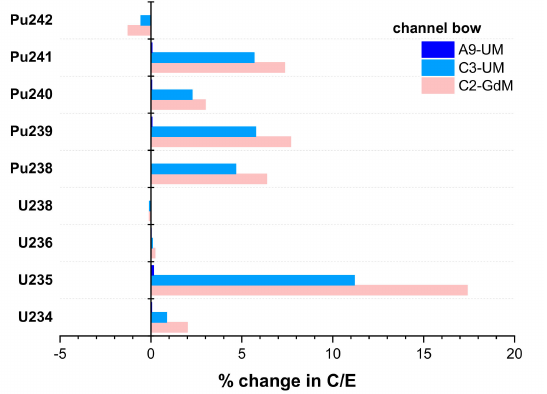
Figure 10. Change in U and Pu C/E isotope concentration ratios due to channel bow for samples from assembly